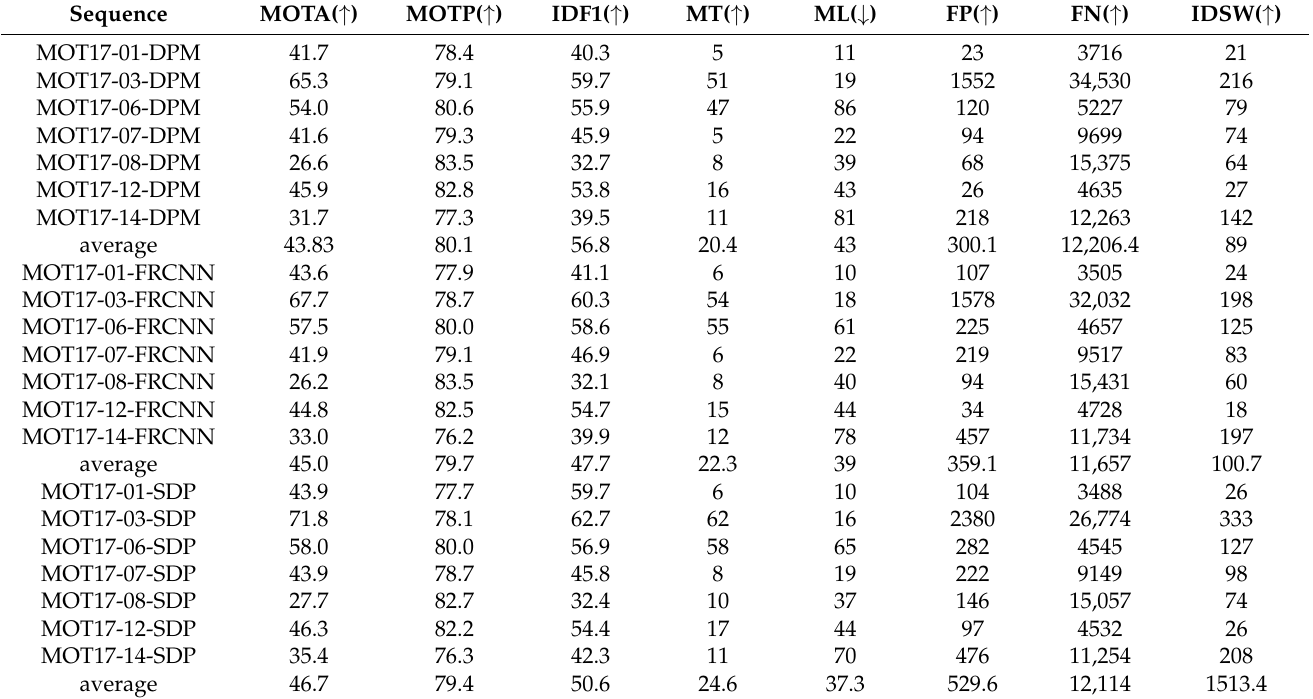
Table 3. Comparison results of different detector algorithms for